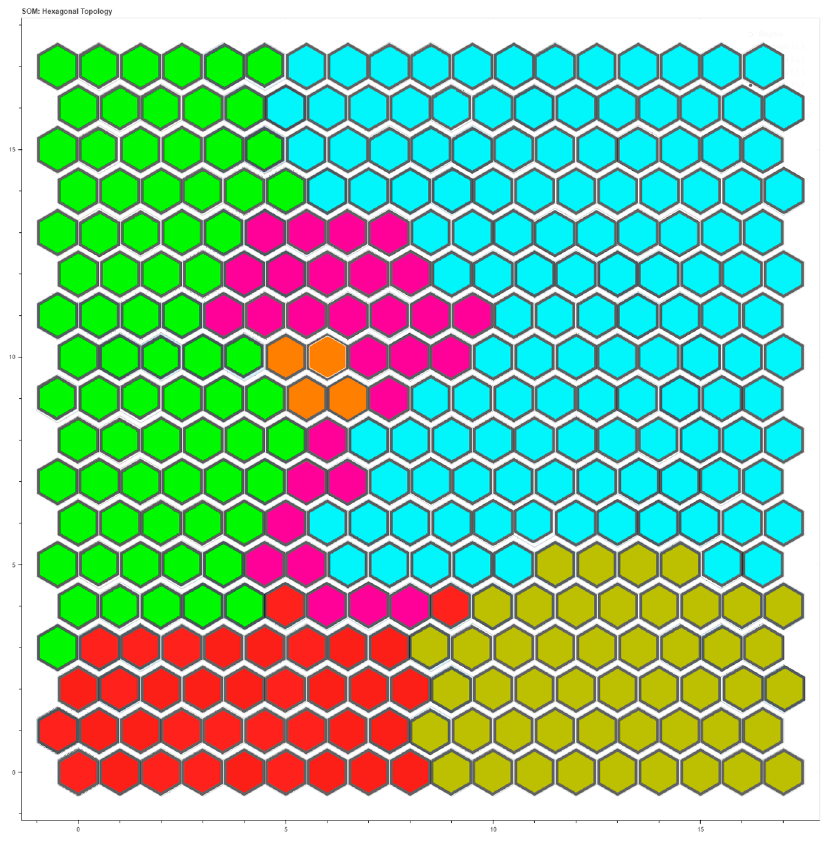
Figure 12. Macro-areas in the output map.